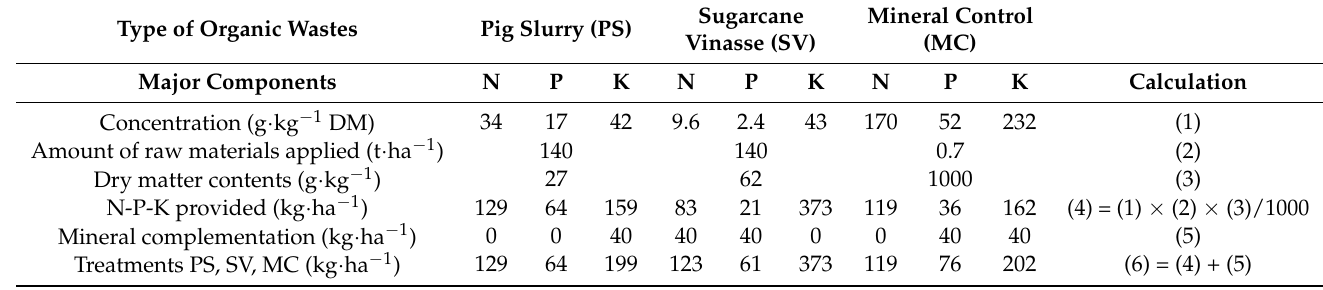
Sugarcane Mineral Control Vinasse (SV) (MC)